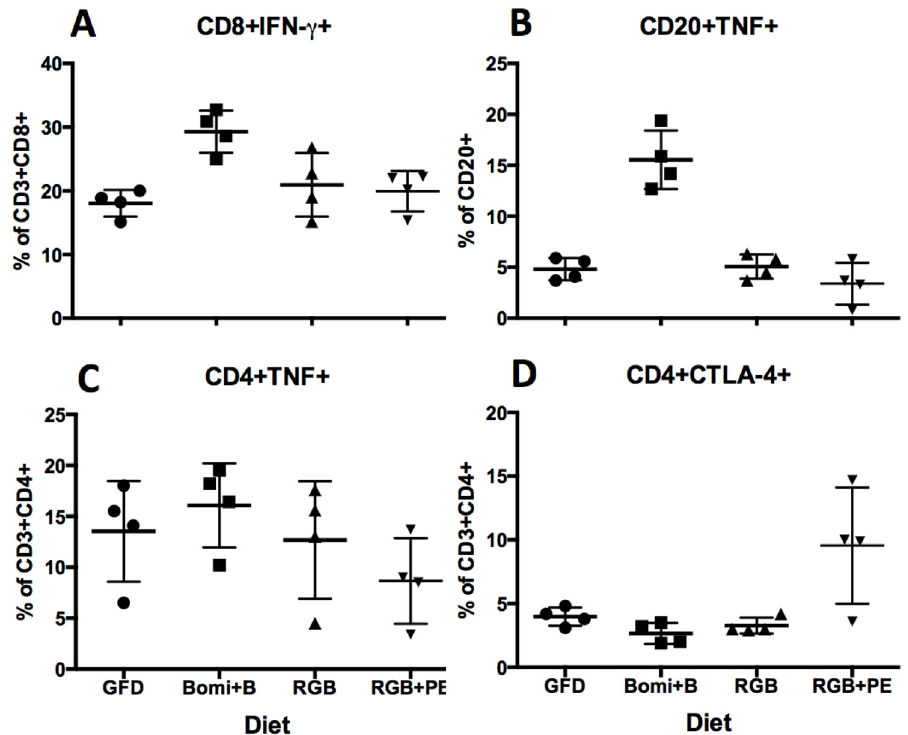
Figure 6. Proportions of pro- and anti-inflammatory mediator expressions by peripheral blood mononuclear cells (PBMCs) following the administration of gluten-modified diets are shown. Significant differences in IFN- γ production between the GFD vs. Bomi + B fed macaques ( p = 0.006) were found ( A ). Bomi + B vs. RGB or RGB + PE fed macaques also differed significantly ( p < 0.05) in IFN- γ production ( A ); A similar but more robust difference ( p < 0.0001) between the Bomi + B fed macaques and other diets was found in the case of TNF production by CD20 + B cells ( B ); Non-significant trends for differences were found in the case of TNF production by CD4 + T cells ( C ) while an increase in expression of anti-inflammatory CTLA-4 (CD152) by CD4 + T cells ( p < 0.05) was observed after the macaques were placed on RGB + PE diet ( D ). Time intervals between indicated measurements correspond to four weeks.